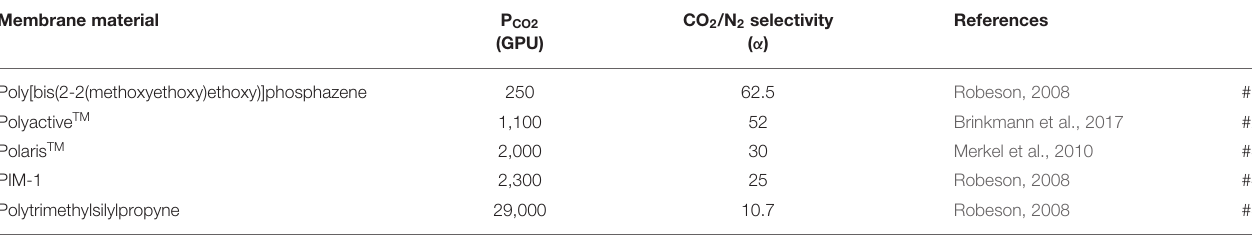
TABLE 2 | Examples of polymeric membrane materials with CO 2 permeance and CO 2 /N 2 selectivity performances. Membrane material